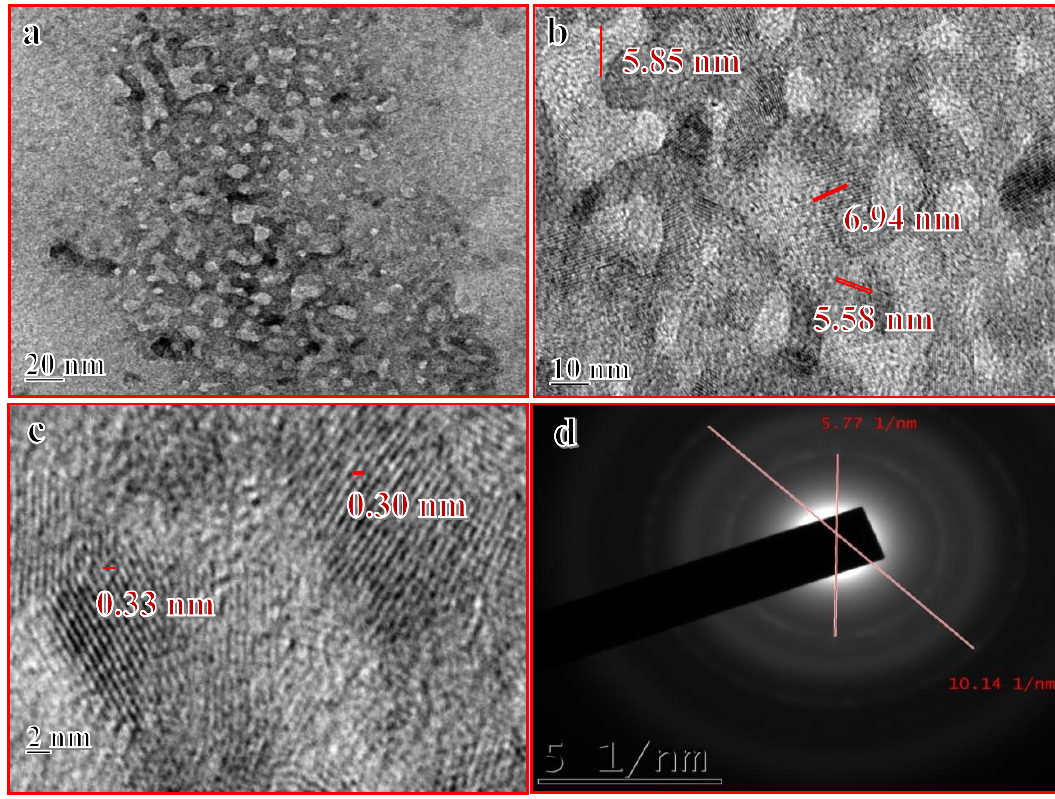
Figure 1. ( a – d ) HRTEM images of Mn:ZnSQDs.